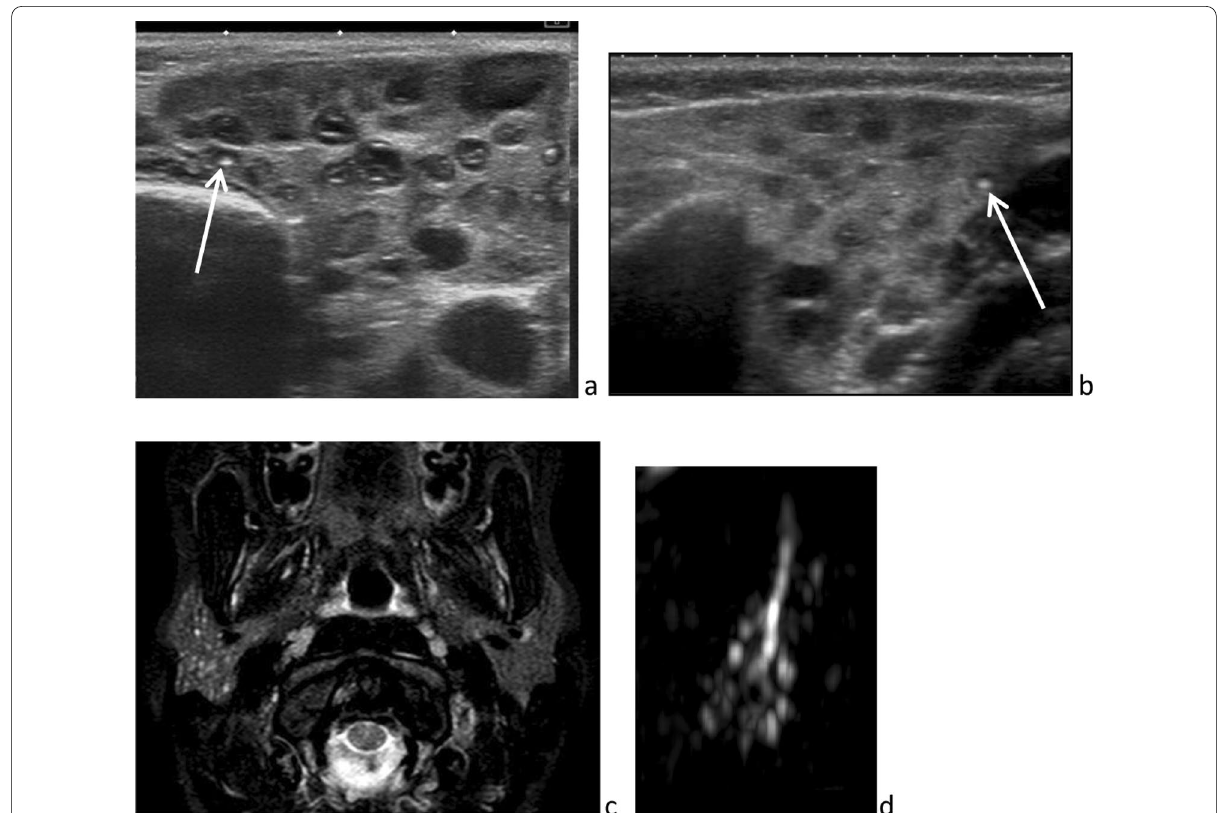
Fig. 8 Juvenile recurrent parotitis. Multiple foci of salivary secretions scattered in a normal sized gland, with some central calcification [white arrow] and without Stensen’s duct dilatation, on ultrasonography ( a and b ), axial fat sat T 2 ‑weighted image ( c ) and MR‑sialography ( d